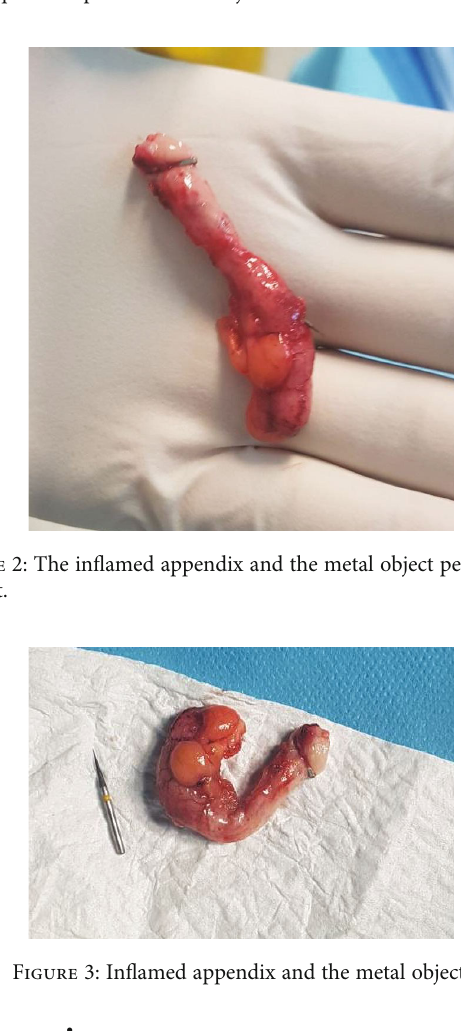
Figure 1: Two abdominal X-ray images of the patient. On the right, abdominal X-ray on fi rst day of foreign body ingestion. On the left, 10 days after foreign body ingestion. Both images shows a right lower quadrant pointed metal object.